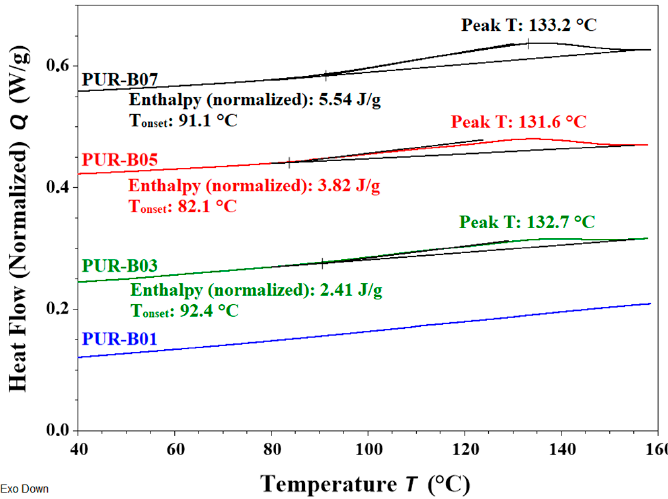
Figure 4. DSC heating curves at 10 °C/min for PUR-B01 and those samples prepared with DAF/FA: PUR-B03 (13.7 %TB), PUR-B05 (18.8 %TB) and PUR-B07 (25.7 %TB).